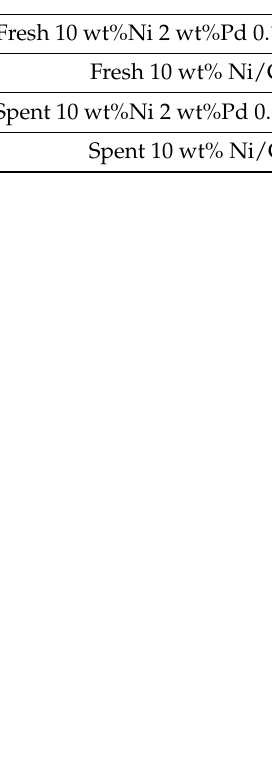
Table 1. BET-BJH results of fresh and spent 10 wt%Ni 2 wt%Pd 0.1 wt%Ir/CeZrO 2 and 10 wt% Ni/CeZrO 2 catalysts.